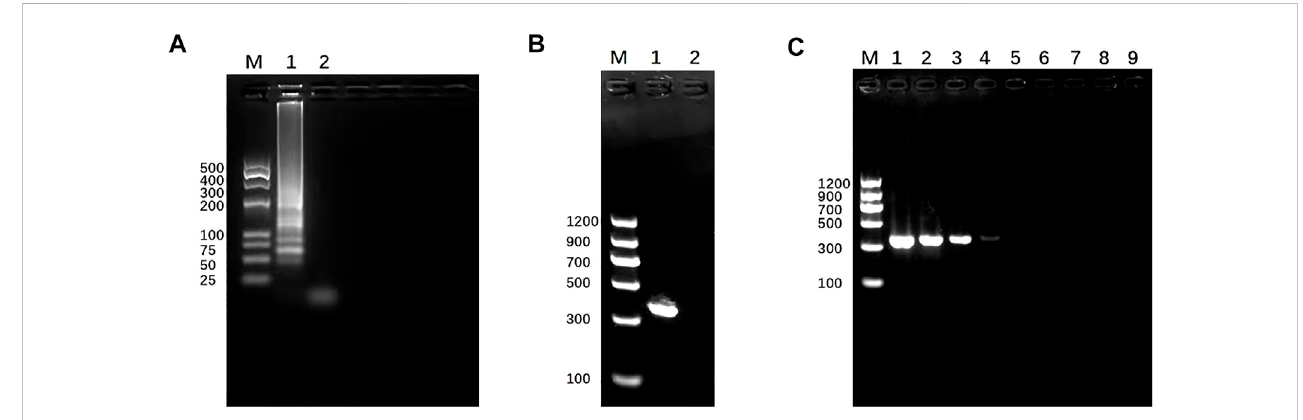
FIGURE 5 Establishmentandidenti fi cationofSEAandPCR. (A) SEAresult.LaneM,DL500DNAmarker.Lane1,SEAproductof mdh for Klebsiellapneumoniae by3% (w/v) agarose gel electrophoresis. Lane 2, negative control. (B) PCR result. Lane M, DL 2000 DNA marker. Lane 1, PCR products of mdh for Klebsiella pneumoniae determined by 1.5% (w/v) agarose gel electrophoresis. Lane 2, negative control. (C) Detection sensitivity of PCR-GE using serially diluted Klebsiella pneumoniae ( mdh ); lane M, DL1200 marker; lanes 1 – 8, DNA concentration from 7.7 to 7.7 × 10 − 7 ng/ μ L. Lane 9, negative control. The size of the PCR products ( mdh ) was 364